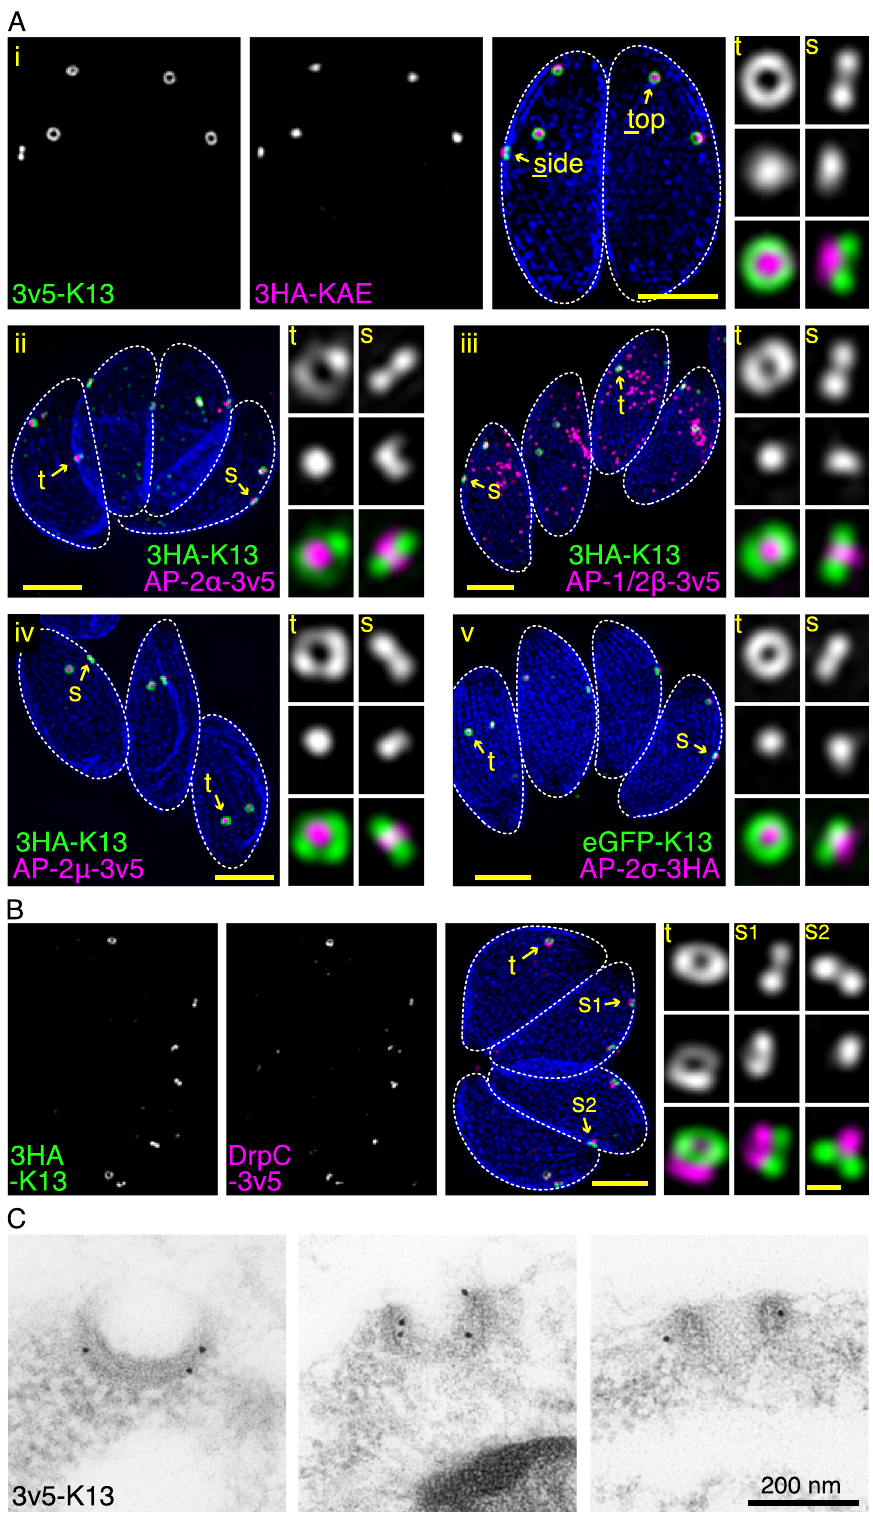
Fig. 1 | Endocytosis-related AP-2 and DrpC associate with K13 at peripheral micropore structures in T. gondii . A Collapsed projections of 3D-SIM images of intracellular parasites within the host cell vacuole showing K13 (green) with fi ve differentAP-2relatedproteins:(i)KAE,(ii)AP-2 α ,(iii)AP-2 µ ,(iv)AP-1/2 β and(v)AP- 2 σ (all magenta). B K13 (green) with dynamin related protein DrpC (magenta). The IMC1(blue)showstheparasiteinnermembranecomplex,andzoomedpanelsshow